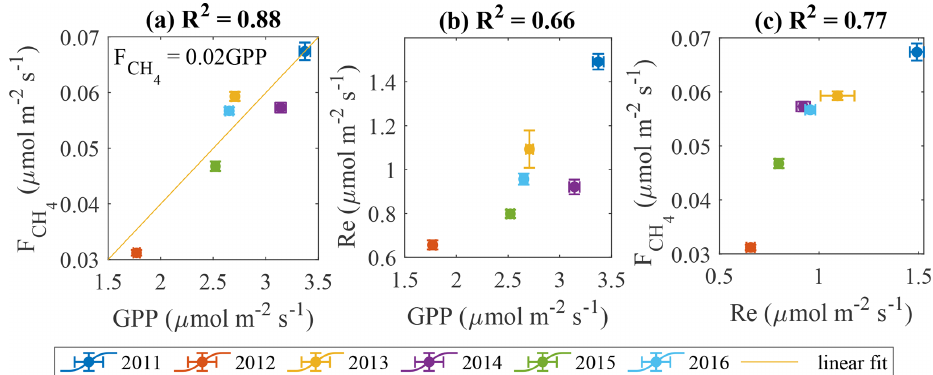
Figure 12. Relationships between the mean measured May–September